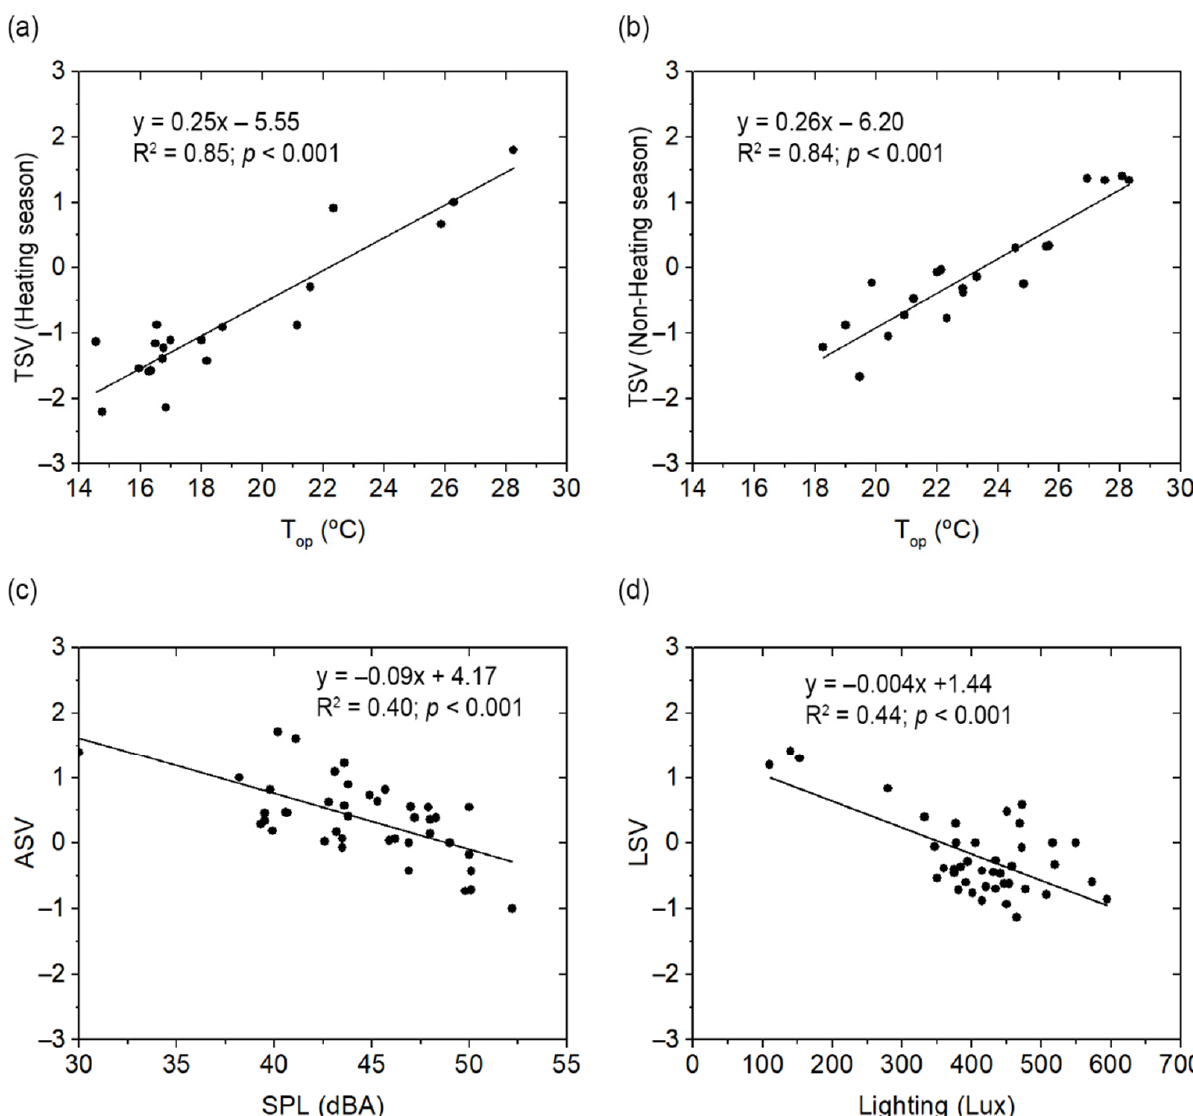
(Table 5). The sensation votes equal to ‘ − 1’, ‘ − 0.5’, ‘0’, ‘0.5’ and ‘1’ were calculated for each environmental factor.